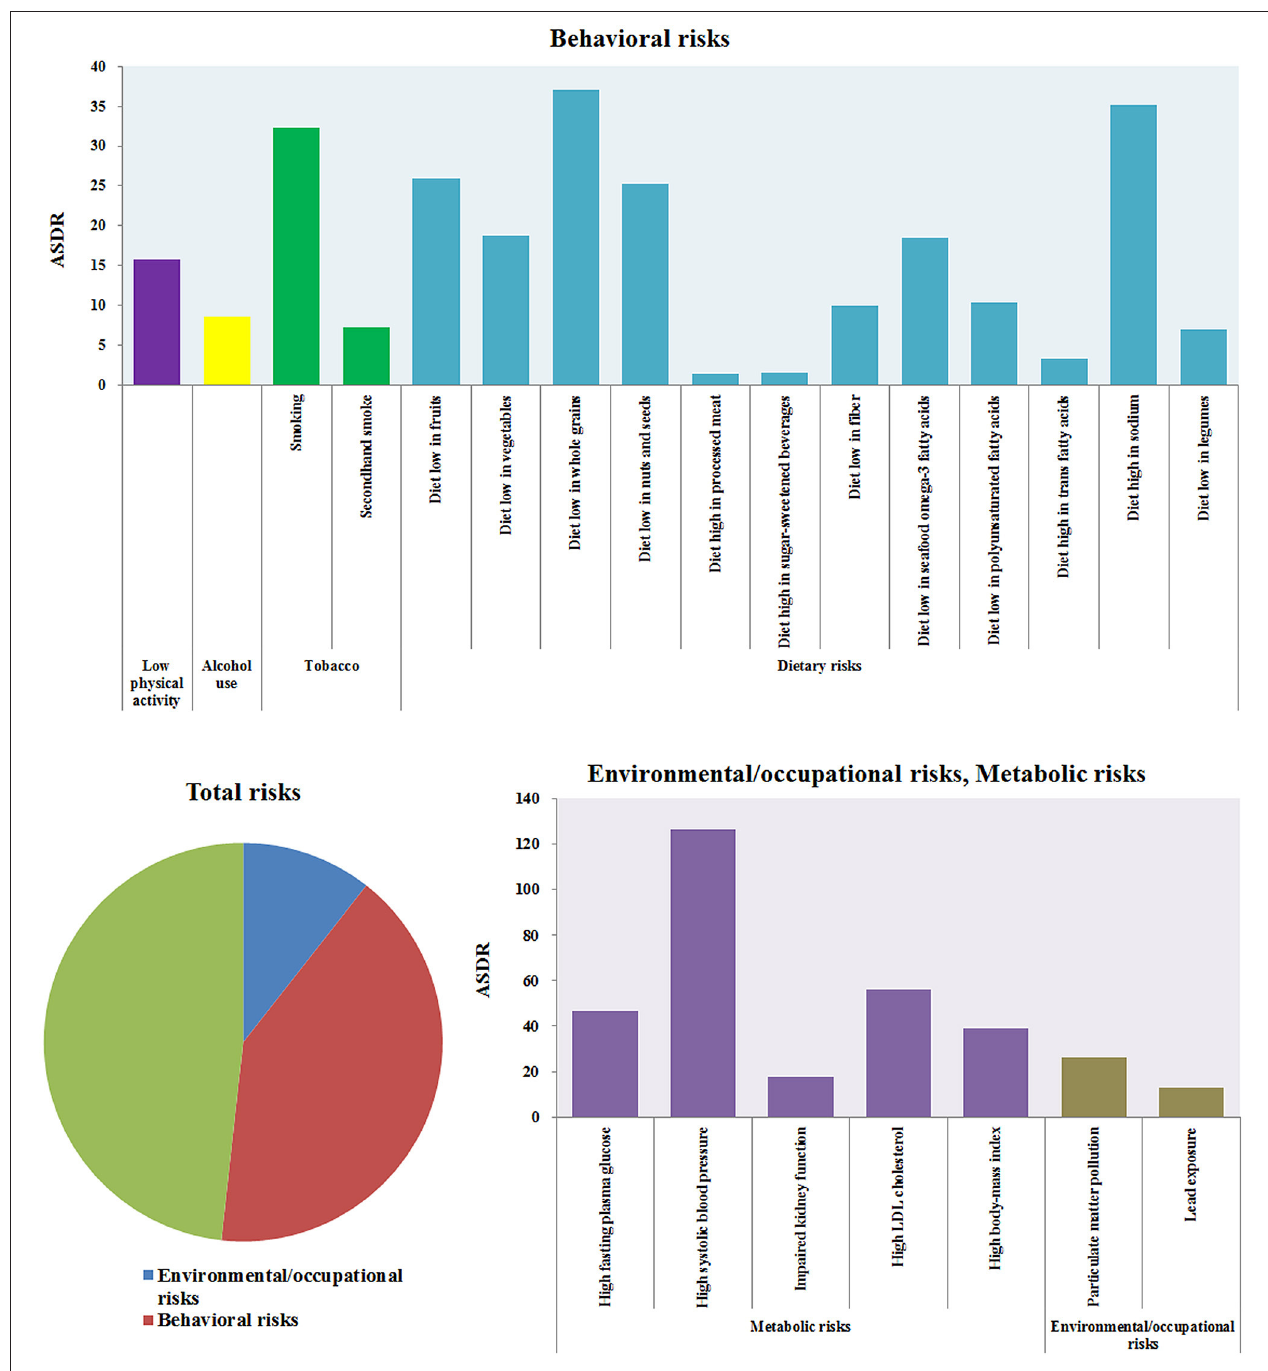
FIGURE 9 | The ASDRs of CVD induced by different risk